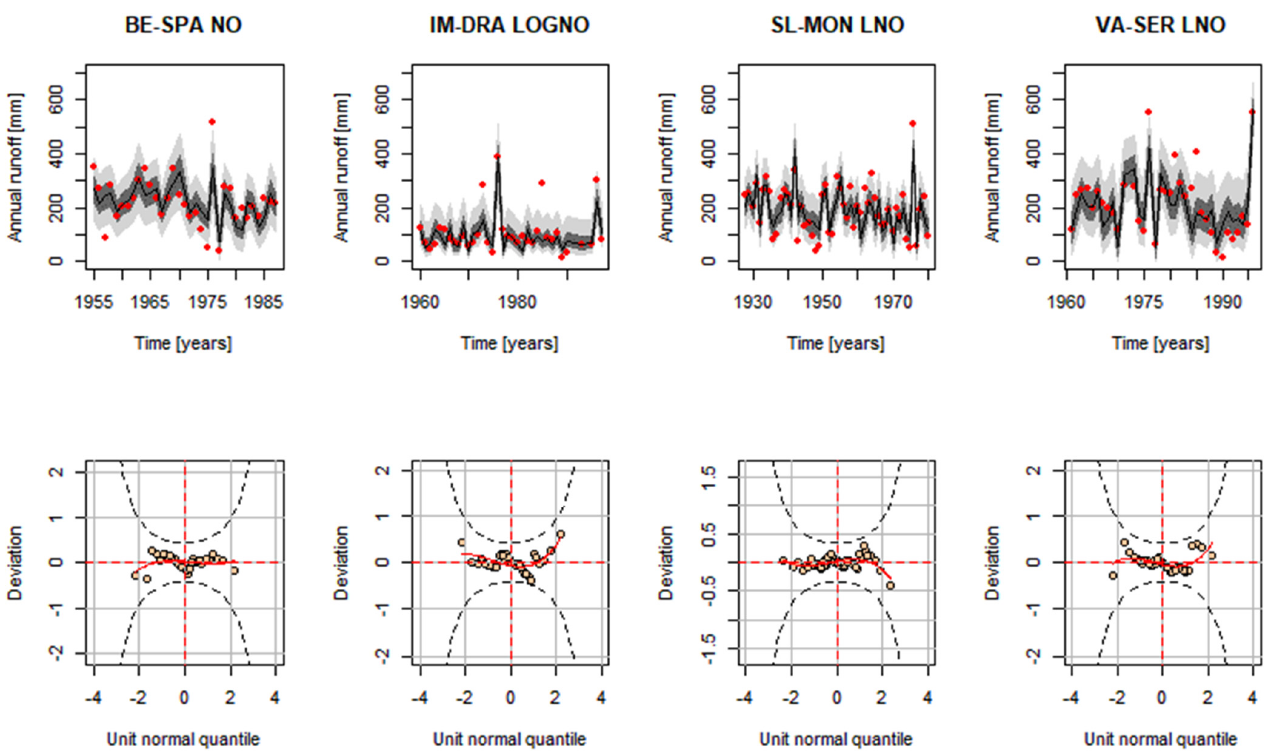
Figure 7. Best suitable distribution centile curves ( first row ) and the corresponding worm plots ( second row ) for the P2 model. The legend for the first line is the same as in Figure 5.